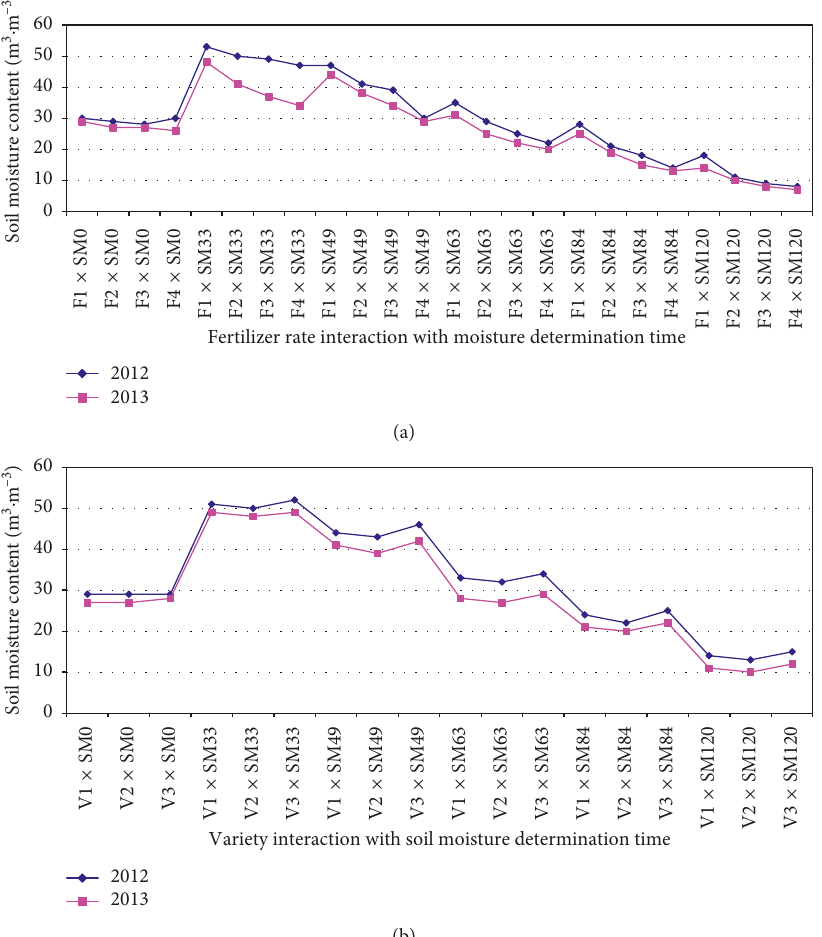
Figure 4: Soil moisture affected by (a) fertilizer rates interacted with SMC determination time (crop growth stage) across years and (b) tef varieties interaction with SMC determination time (crop growth stage) across years. Note: F (N+P) denotes fertilizer N plus P (kg · ha − 1 ) as 0 N +0 P (F1), 21 N +10 P (F2), 41 N +20 P (F3), and 64 N +25 P (F4); SM refers to soil moisture determined at 0, 33, 49, 64, 84, and 120days after sowing